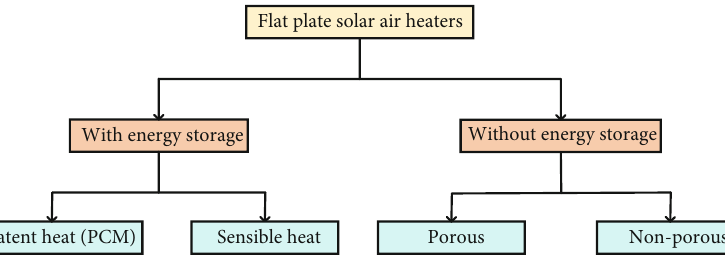
Figure 5: Classi fi cation of fl at plate SAHs: without and with energy